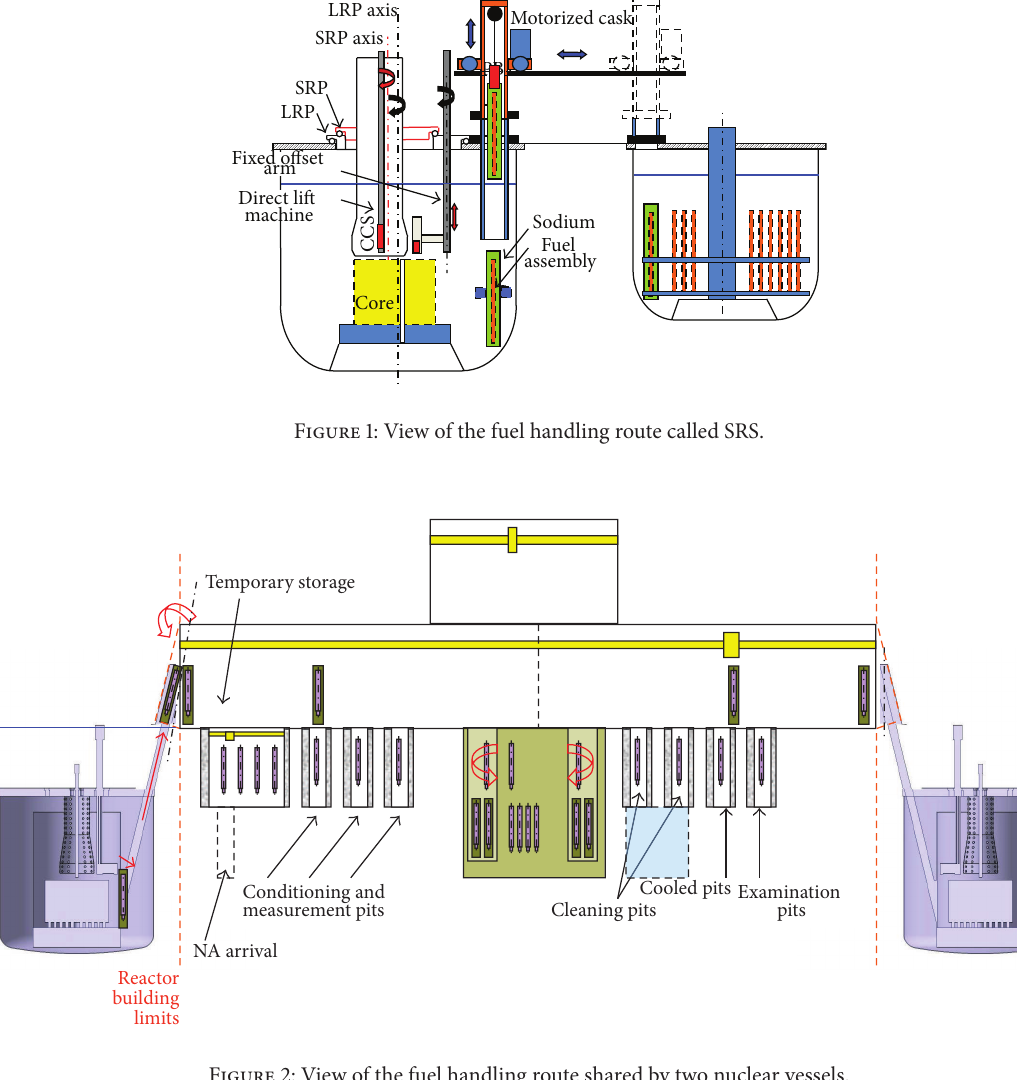
Figure 2: View of the fuel handling route shared by two nuclear